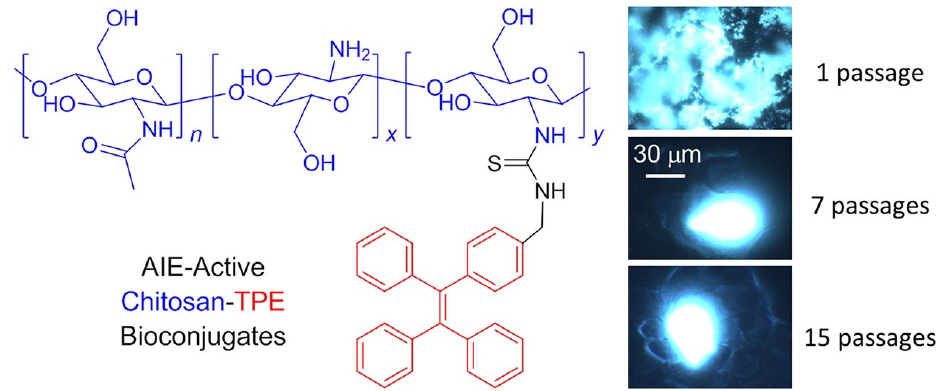
biological cell imaging in HeLa cells. Reprinted from reference [76] with the permission of the Jour- nal of the American Chemical Society.